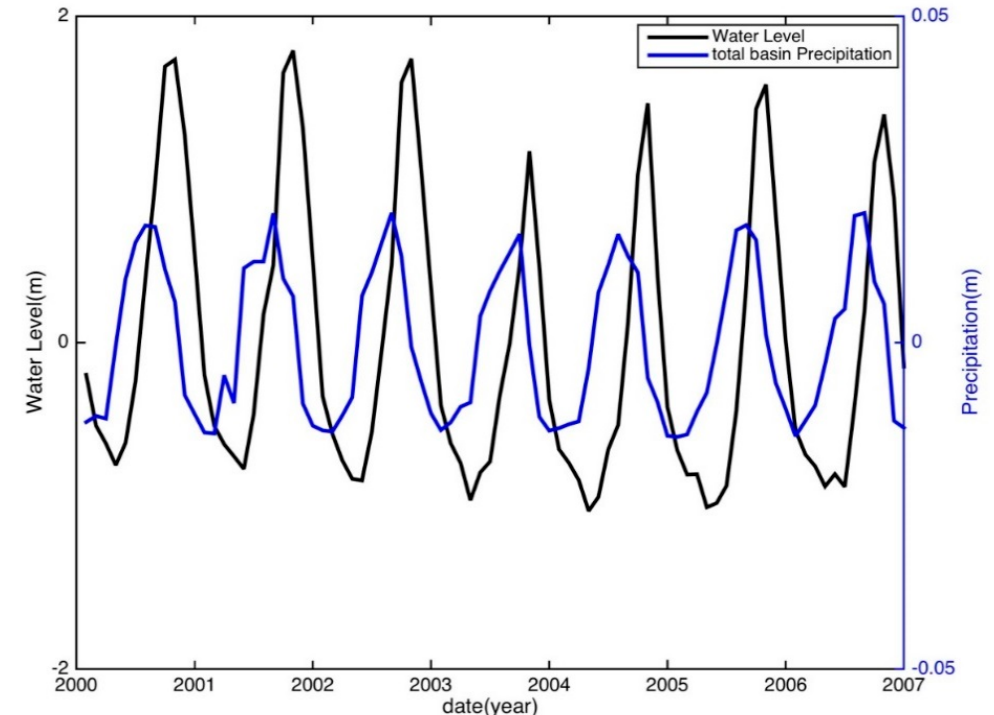
Figure 3. Time series of water level and basin-averaged TRMM precipitation in the MRB.